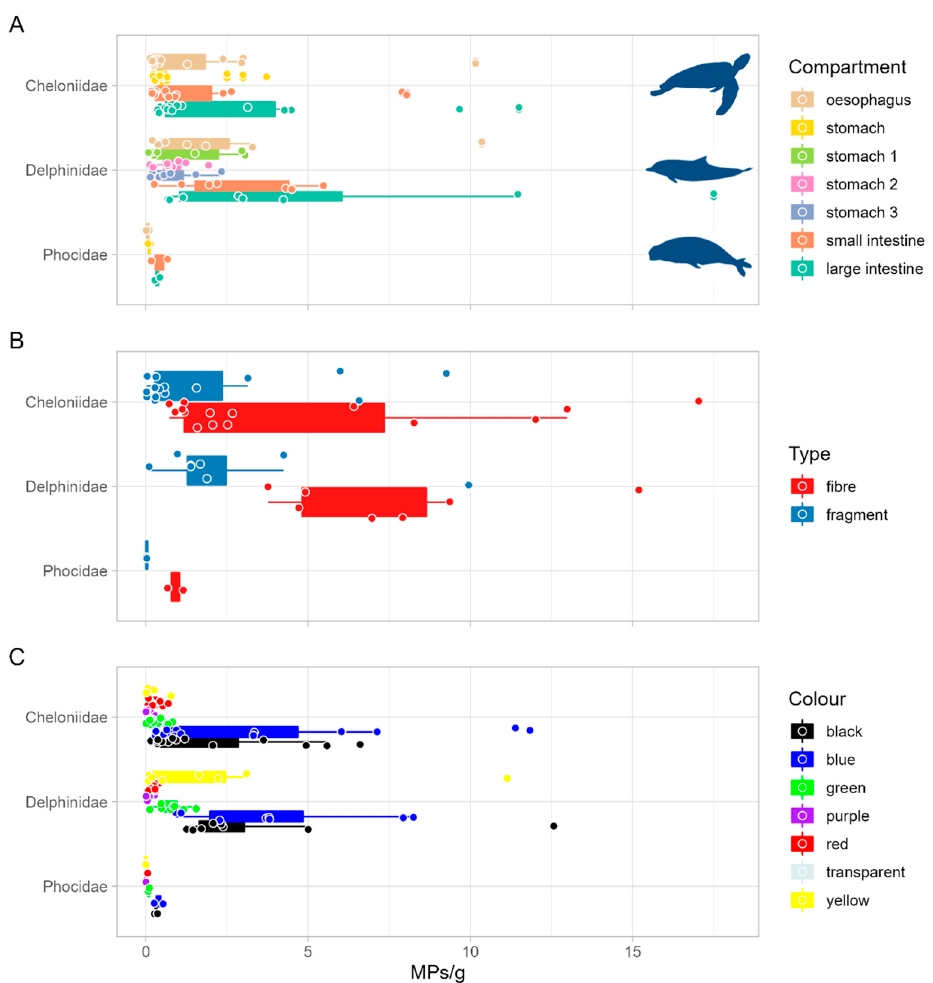
Figure 4. Occurrence of MPs (in MPs/g) per compartment ( A ), type ( B ) and colour ( C ) in the three families analysed. For graphical purposes, only colours with a proportion higher than 1% are shown.